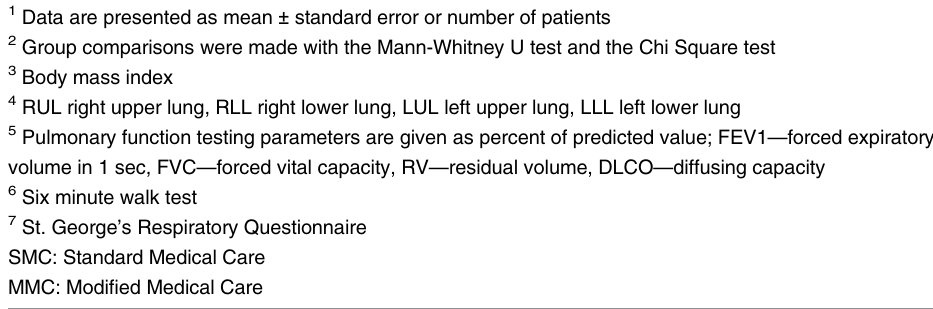
lung anatomy. The target lobe for treatment was the CV negative lobe with the highest emphy- sema distribution and/or lung destruction. For the bronchoscopic anaesthesia, midazolam and propofol were used. For ELVR all patients were admitted to the hospital and the hospital stay was similar in both groups (Table 1). In all patients, chest X-rays were taken before ELVR, one and three days after ELVR, and on the day of discharge to evaluate signs of lung volume reduc- tion and to rule out a pneumothorax. All chest X-rays taken during hospitalization were retro- spectively reassessed by two radiologists who were blinded to the study groups and results. Atelectatic signs in X-rays were defined as the detection of patchy opacities, mediastinal shift or elevation of the diaphragm. Patients were discharged in a clinically stable condition after at least four days following ELVR. A complicated pneumothorax was defined as a patient receiv- ing a chest tube for treatment of a pneumothorax for more than five days. An exacerbation was